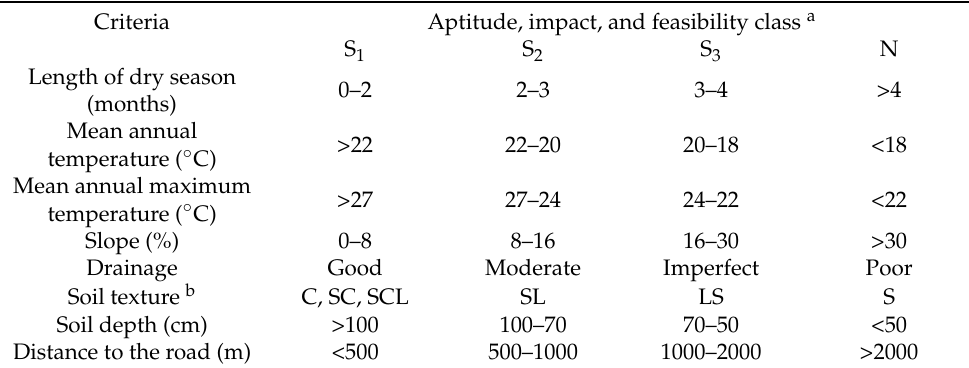
Table 3. Agricultural land suitability evaluation